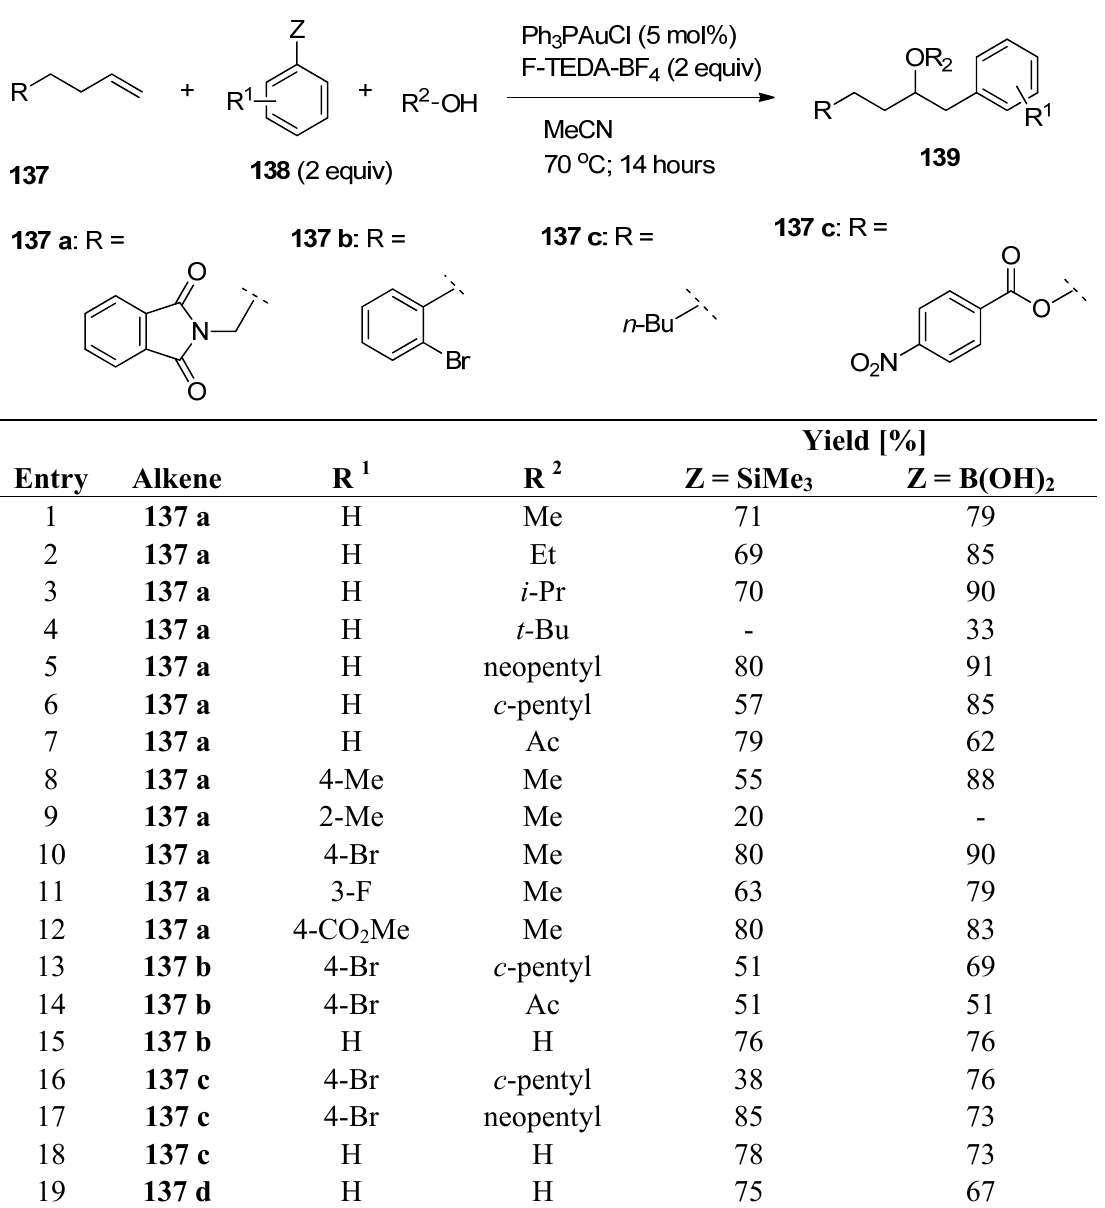
Table 14. Gold-catalyzed and F-TEDA-BF using arylsilanes [73] or arylboronic acids